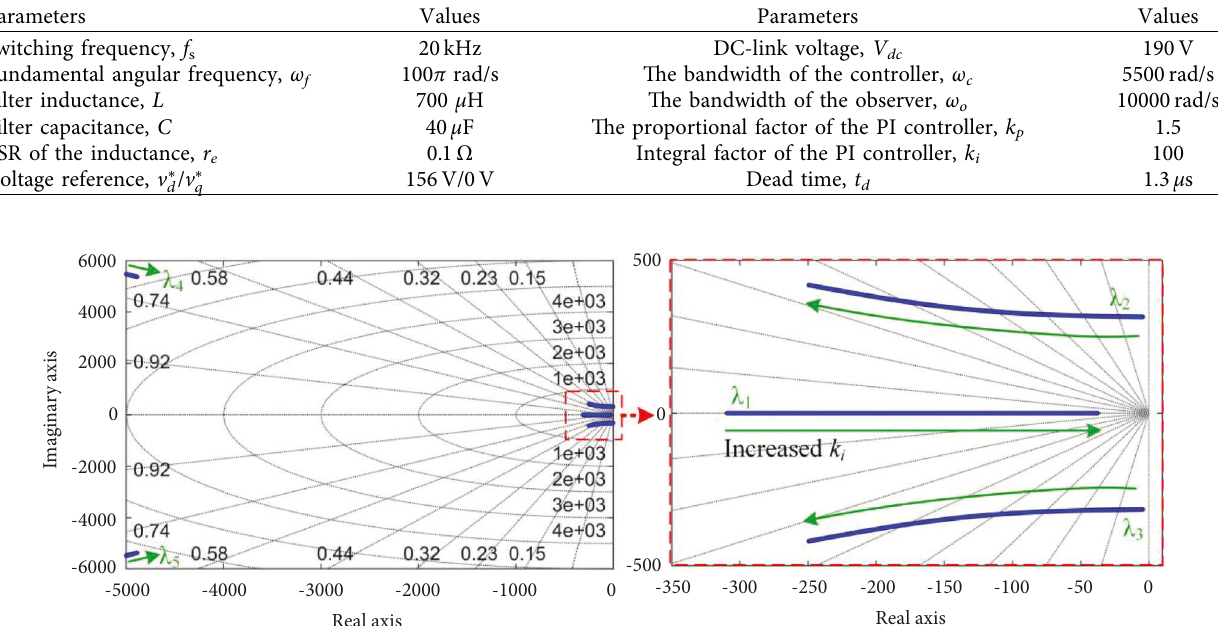
Figure 10: Generalized root locus diagram with a variation of k 1.5